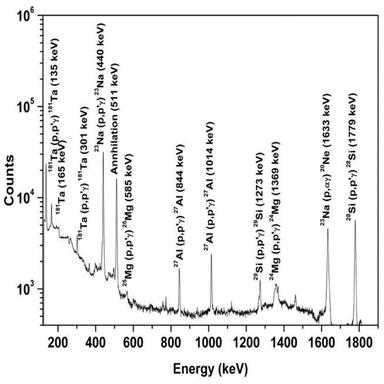
Typical Gamma-ray spectrum of windshield glass using 3.75 MeV proton beam.